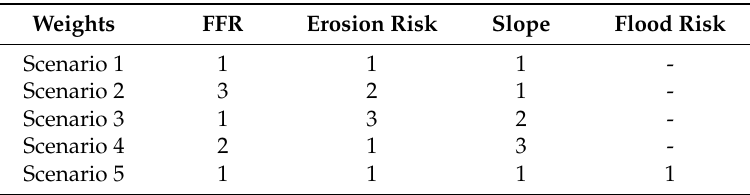
Figure 9. Maps involved in the decision making tool. Table 2. Scenarios’ weights. FFR, Forest Fire